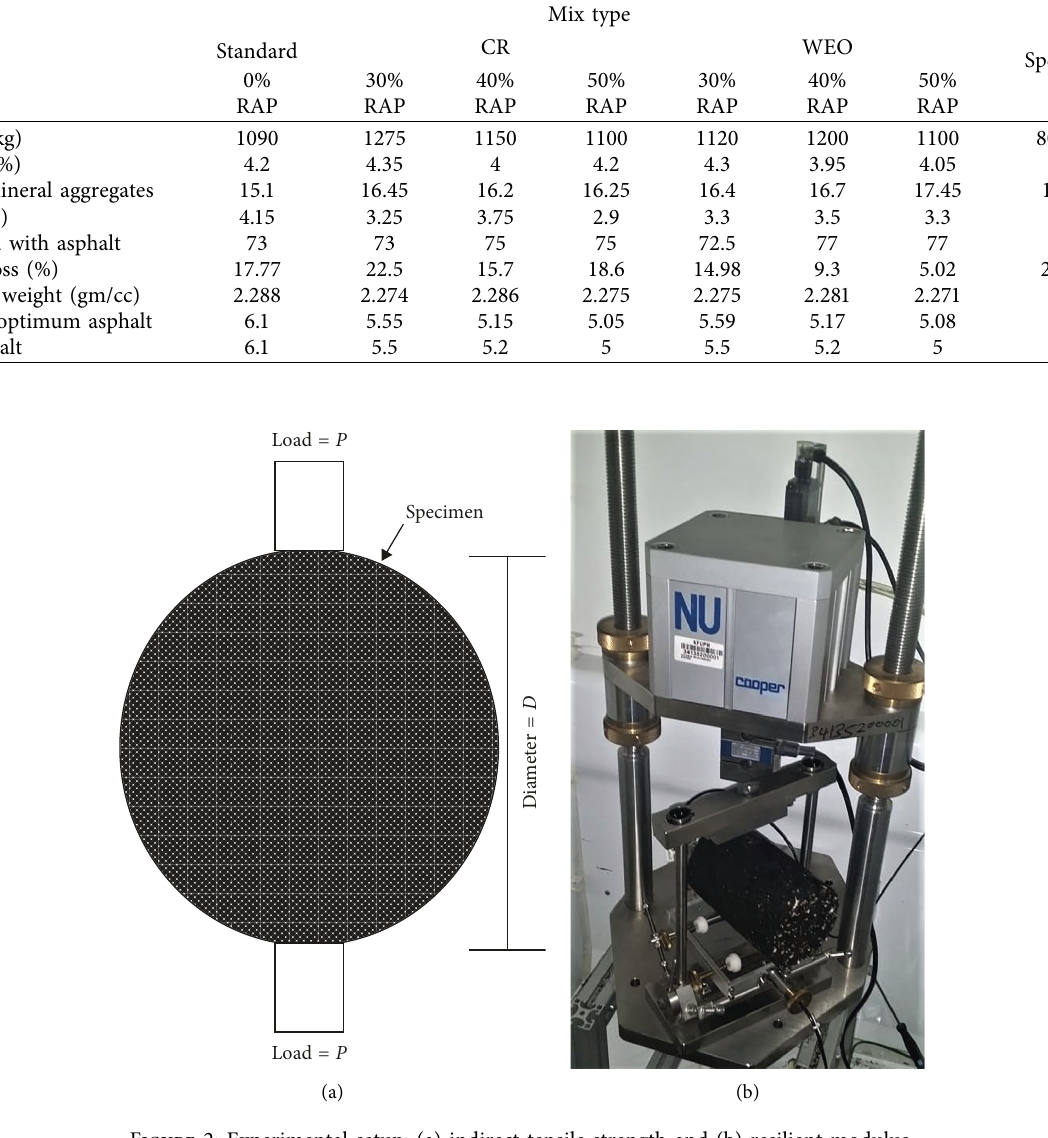
Figure 2: Experimental setup: (a) indirect tensile strength and (b) resilient